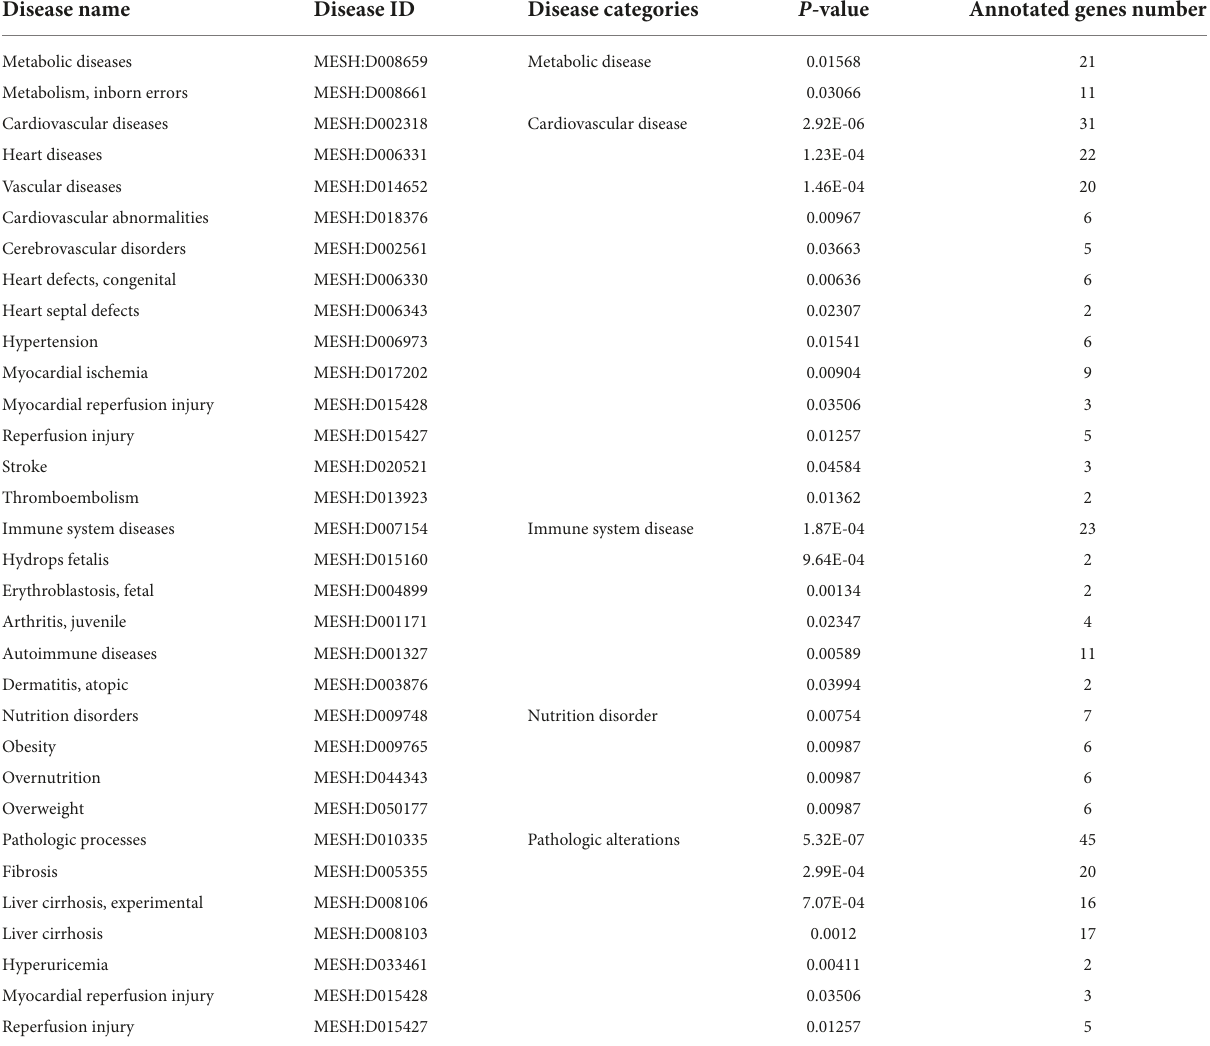
TABLE 2 Associations of gene expression profile of consumption of anthocyanin-rich black beans extract with known human diseases. Disease